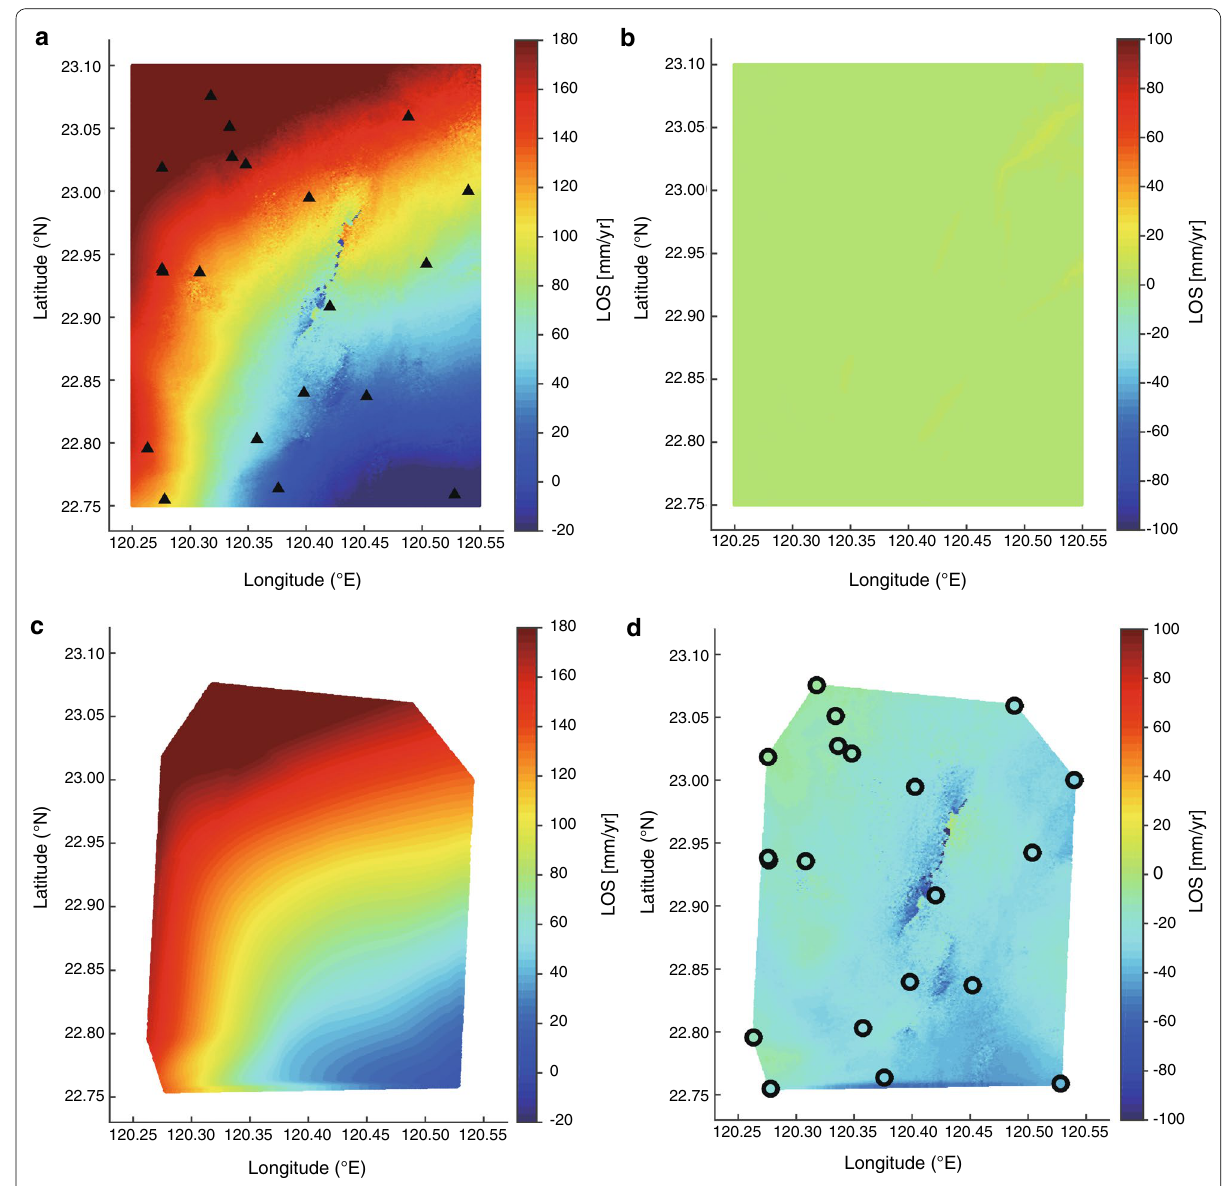
Fig. 2 Interferogram correction for the pair 20071020–20100312 spanning 874 days. Color indicates the length change velocity in the line-of-sight (LOS) direction. a Original interferogram. Black triangle indicates the GNSS station. b Height-dependent component. c Long-wavelength noise. d Corrected interferogram. Colored circle indicates the LOS velocity calculated from the GNSS